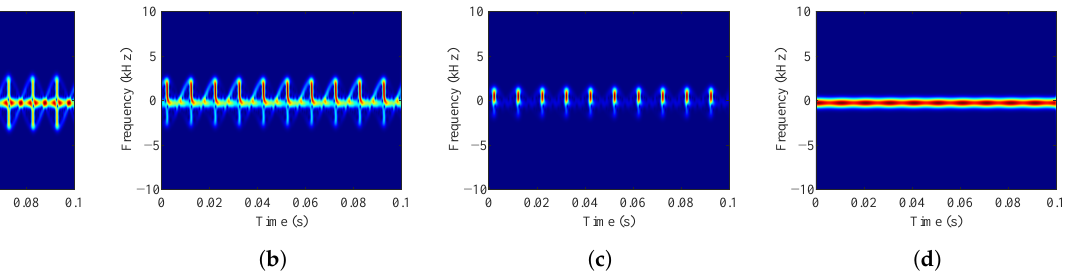
Figure 4. Blade spin time–frequency spectrum electromagnetic simulation in different radar observa- tion angles (Type 1). ( a ) 0 ◦ . ( b ) 30 ◦ . ( c ) 60 ◦ . ( d ) 90 ◦ .